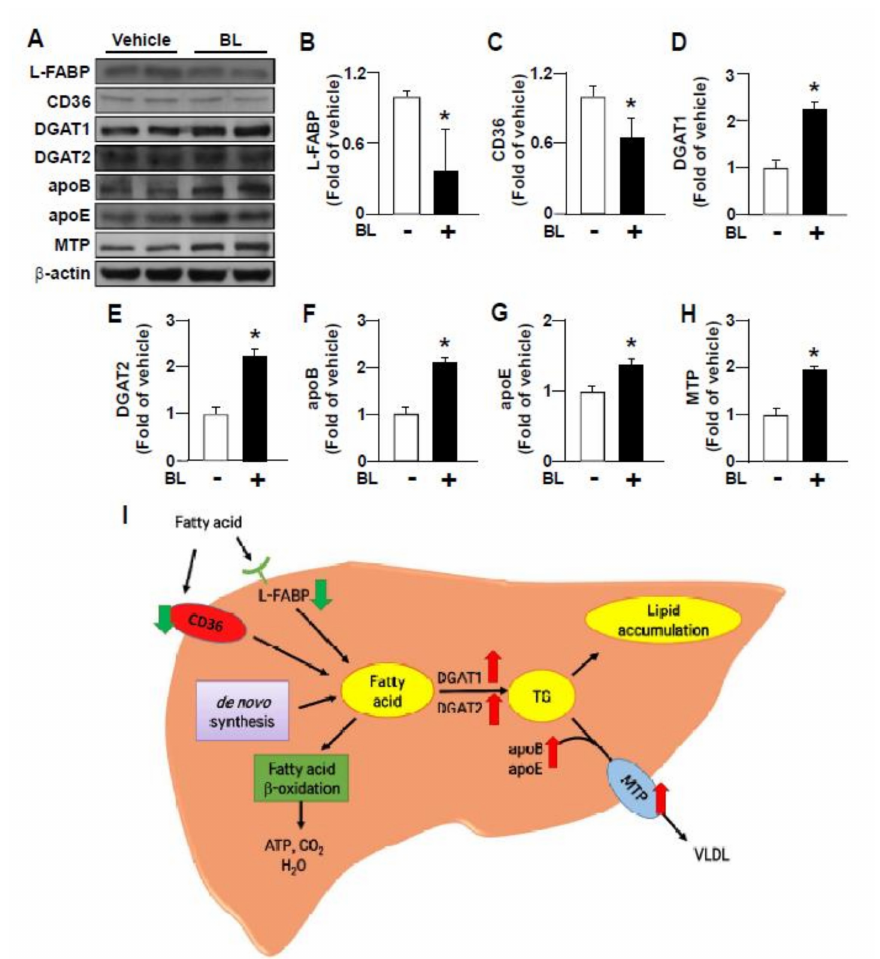
Figure 5. E ff ect of bromelain on the expression of proteins involved in the hepatic fatty acid (FA) metabolism of HFD-fed mice. Eight-week-old C57BL / 6 mice were fed with HFD and bromelain (20 mg / kg) or vehicle (PBS) for 12 weeks. ( A – H ) Western Blot analysis of protein levels of L-FABP, CD36, DGAT1, DGAT2, apoB, microsomal triglyceride transfer protein (MTP) and β -actin. ( I ) The summary of the e ff ect of bromelain on FA metabolism in the liver. Results are presented by the mean ± SEM from 10 mice. * p < 0.05 vs. vehicle group. BL: